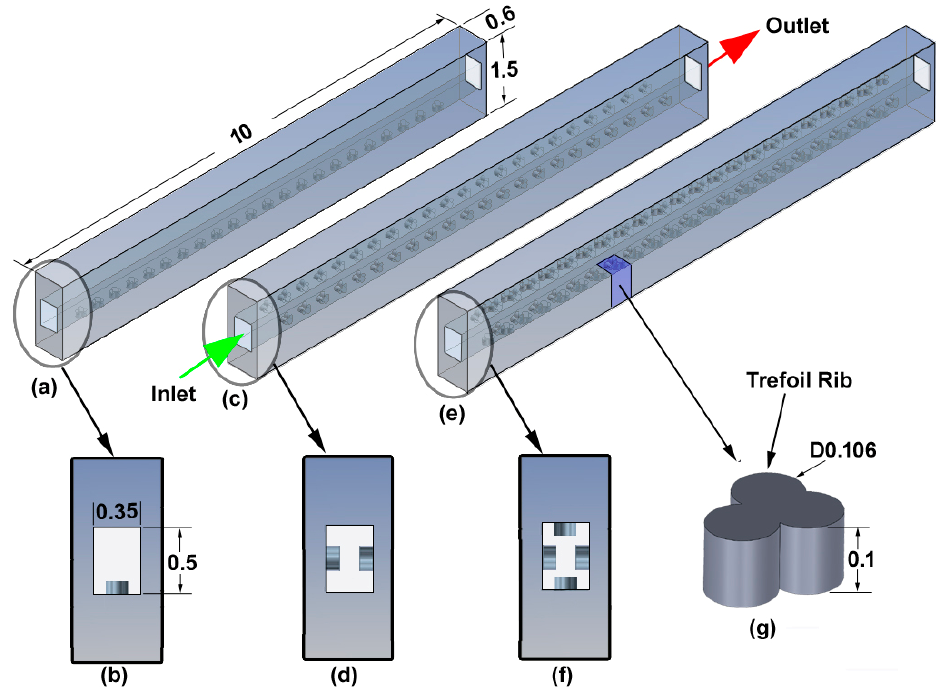
Figure 1. Computational domain of ( a , b ) MC-BWTR, ( c , d ) MC-SWTR, ( e , f ) MC-AWTR and ( g ) geometric details of trefoil rib.